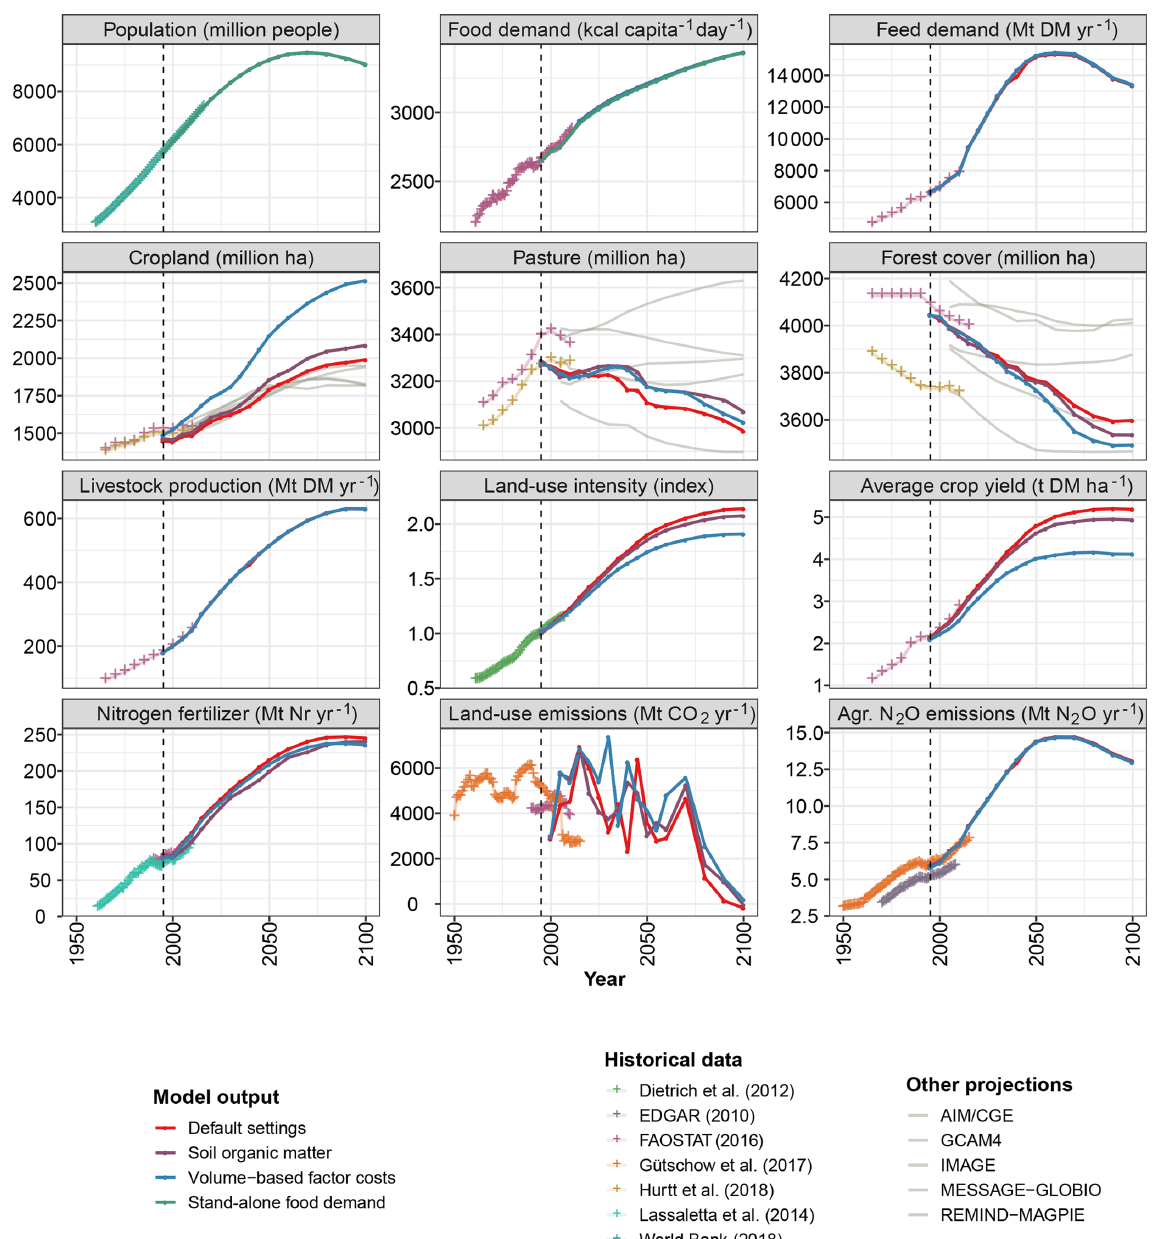
Figure 2. Evaluation plots for MAgPIE 4 inputs and outputs for the default settings, a run with soil organic matter explicitly modeled, a run with an alternative factor requirement setup with costs proportional to the production volume and a stand-alone run of the food demand module. Sources of historical data: Dietrich et al. (2012), EDGAR (2010), FAOSTAT (2016), Gütschow et al. (2017), Hurtt et al. (2019), Lassaletta et al. (2014) and World Bank (2018). Sources of other projections for SSP2 reference scenario: IAMC